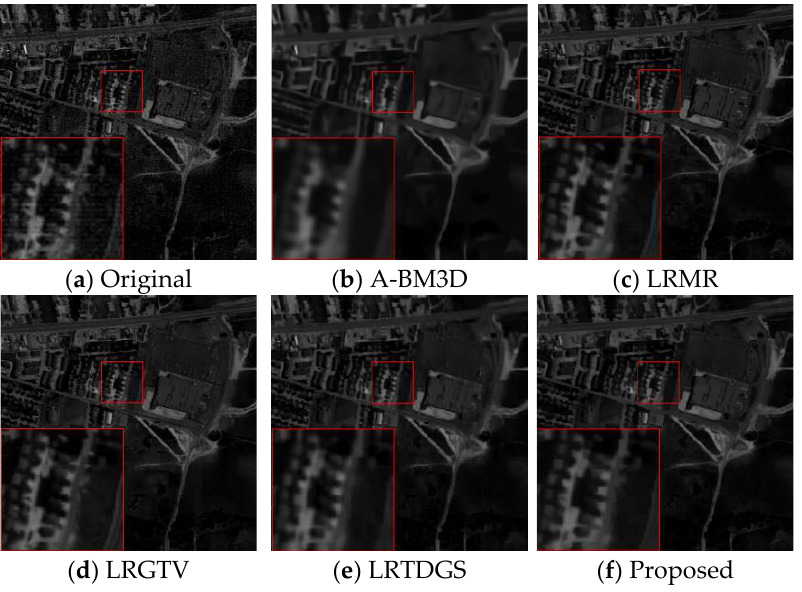
Figure 11. Restoration results on HYDICE urban image set: moderate noise band.